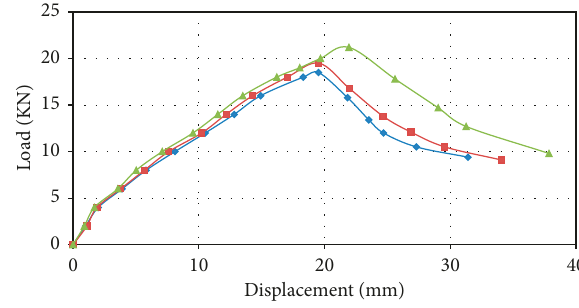
Figure 9: Grouted anchor pullout force versus